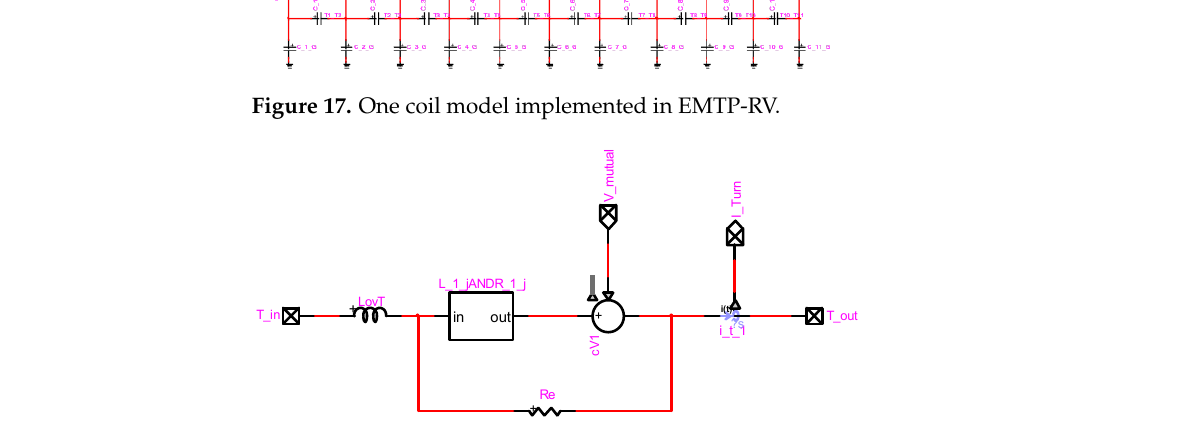
Figure 18. One turn model implemented in EMTP-RV.